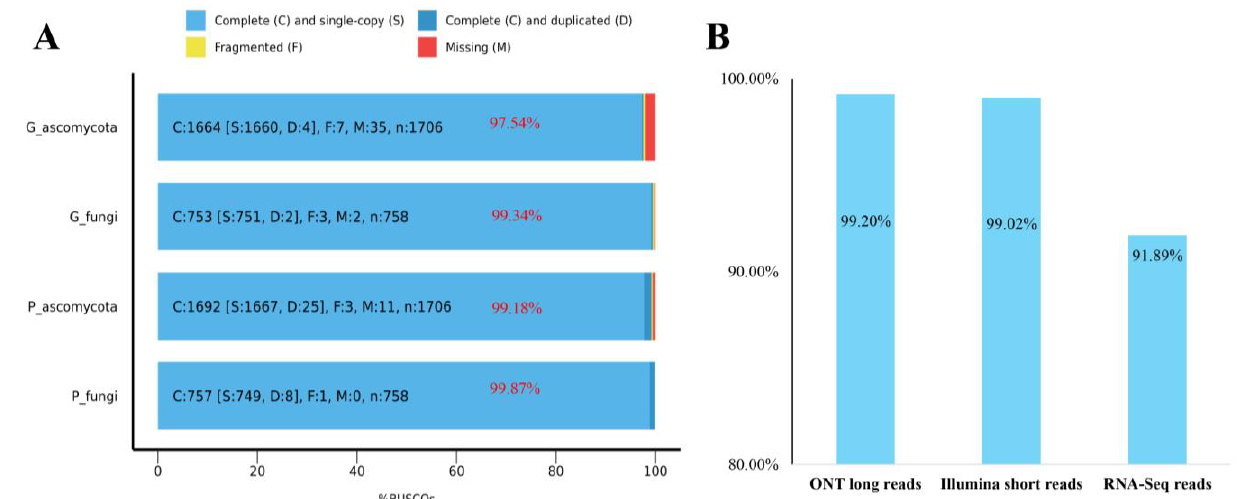
Figure 4. Genome completeness assessment of Stagonospora tainanensis strain StFZ01. ( A ) BUSCO completeness assessment of genome assembly and annotated proteins with the lineage dataset of fungi_odb10 and ascomycota_odb10. G means genome and P means proteins. ( B ) Genome completeness valued by mapping rate of different reads.